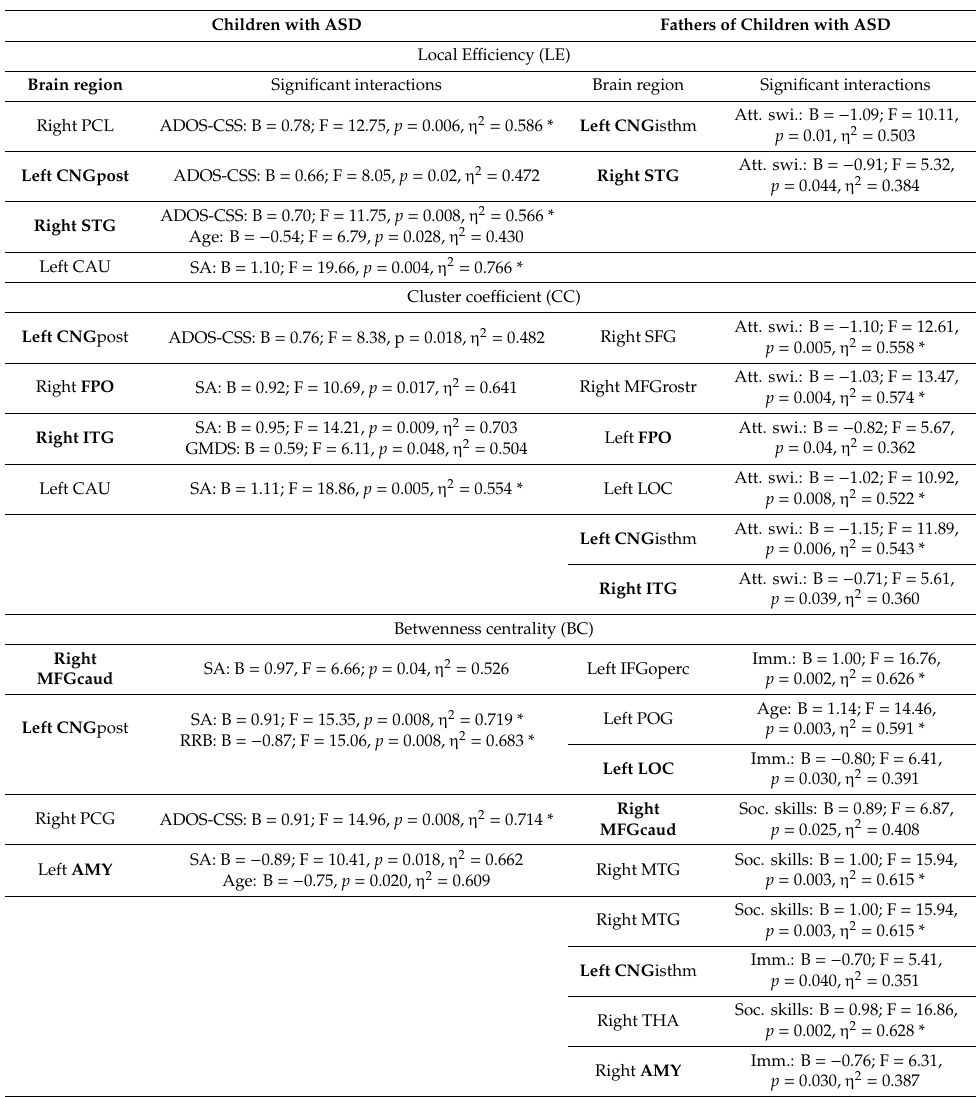
Table 4. Significant correlations between nodal measures and psychological measures in children with Autism Spectrum Disorders (ASD), and in their fathers. Only correlations that survived false discovery rate (FDR) correction and / or were obtained in the same brain areas in the two groups are